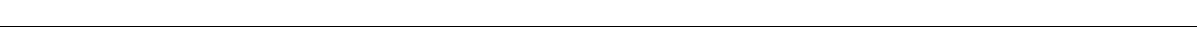
Fig. 6 A limited range of cultured core symbiont strains recycle N in vitro. Results summarize fi ndings from symbionts of fi ve cephalotine ant species, including four from the genus Cephalotes and one from its sister genus Procryptocerus . a Genes and pathways used by specialized gut symbionts to recycle the N-wastes uric acid and urea. The conserved architecture for clusters of symbiont N-recycling genes is illustrated. Red boxes within these pathways represent the metabolic steps assayed for ( b ). b Shown at left are phylogenies of cultured symbionts subject to metabolic assays in vitro and their closest relatives in the NCBI database, which are highlighted with taxon-speci fi c, colored boxes. Most cultured isolates had 16S rRNA sequences that were identical or highly related to at least one sequence obtained from a Cephalotes ant through culture-independent means. Genomes from such isolates also showed high similarity to abundantly represented scaffolds from our metagenomes (Supplementary Fig. 15). Nodes for cultured symbionts are connected to relevant rows within data tables, where the results of assays for urea production and urea degradation assays are illustrated. Asterisks highlight isolates with a sequenced genome; for each of these, in vitro results matched expectations derived from genome content. Additional symbols used in the urea production table indicate whether allantoin boosted urea production and whether urea production was completely allantoin dependent, and hence likely dependent on uric acid metabolism (e.g., urea can separately be produced through arginine metabolism). Three biological replicates were run as a single trial for 13 symbionts subjected to the urea production assay. For four strains we ran one or two additional trials (Supplementary Data 5). Statistical analyses included a two-way, repeated measures ANOVA to examine an effect of allantoin on urea production, an effect of time, and an interaction between these two factors. Holm – Sidak tests were then used for pairwise comparisons between treatments (e.g., allantoin presence vs. absence) at particular time points, for all trials with a signi fi cant effect of treatment or a treatment by time interaction